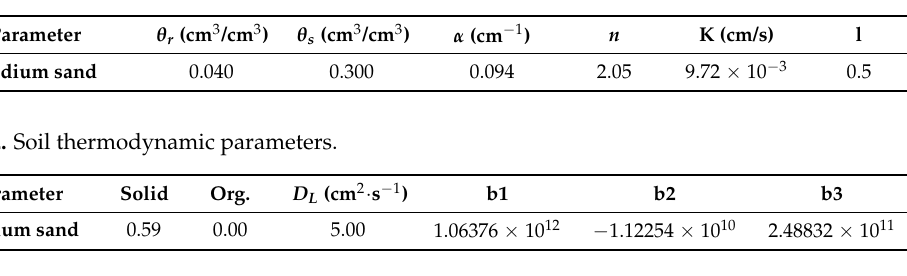
Table 1. Soil hydraulic parameters.